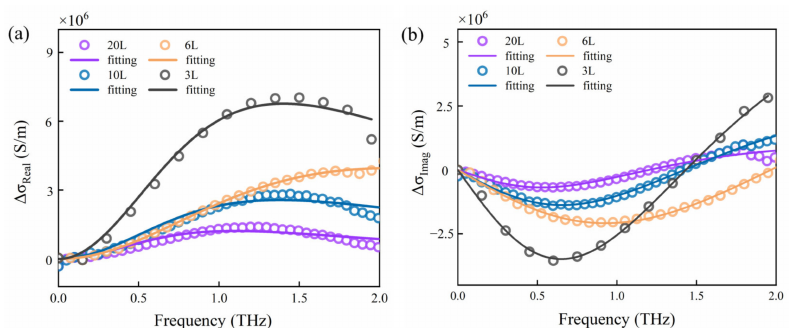
Figure 3. Changes in photo-induced conductivity ∆ σ of PtSe 2 films with different layers. ( a ) Real part; ( b ) imaginary